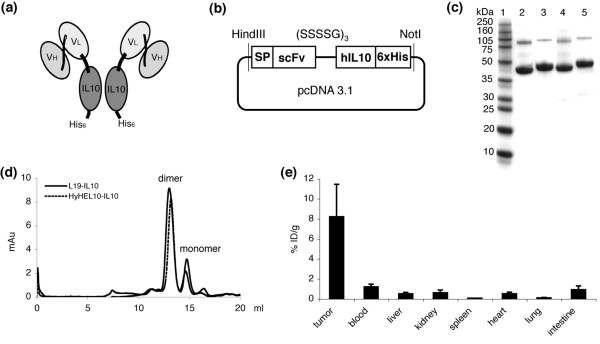
Cloning, expression and purification of L19–IL-10 and HyHel10–IL-10. (a) Schematic representation of single-chain variable fragment-IL-10 fusion proteins. (b) Schematic representation of a pcDNA3.1 vector (Invitrogen Basel, Switzerland) containing the essential elements of the L19–IL-10 or HyHEL10–IL-10 fusion proteins. The human IL-10 moiety was fused to the C-terminal of the single-chain Fv antibody fragment by the 15 amino acid linker (SSSSG)3. The secretion sequence at the N-terminal is required for secretion of recombinant proteins and the His6 tag at the C-terminal of human IL-10 was used for detection of the fusion proteins. (c) SDS-PAGE analysis of purified fusion proteins: lane 1, molecular-weight marker; lanes 2 and 3, L19–IL-10 under nonreducing and reducing conditions, respectively; lanes 4 and 5, HyHEL-IL-10 under nonreducing and reducing conditions, respectively. Monomeric fusion proteins are expected to have a molecular weight of 46 kDa. (d) The size-exclusion chromatography profile of purified L19–IL-10 (Superdex 200, GE Healthcare, Duebendorf, Switzerland). The peak eluting at a retention volume of 13 ml corresponds to the noncovalent homodimeric form of L19–IL-10, the smaller peak eluting at a retention volume of 16 ml corresponds to the monomeric fraction. (e) Biodistribution profile of L19–IL-10 in 129Sv mice grafted with a subcutaneous F9 tumour (n = 4). L19–IL-10 was labelled with 125I and administered by intravenous (i.v.) injection into tumour-bearing mice (3 μg corresponding to 4 μCi L19–IL-10 per mouse). Mice were sacrificed 24 hours after injection and the tumours and organs were weighed and counted. Values are displayed as percent injected dose per gram (%ID/g); standard errors of the means (SEMs) are indicated.